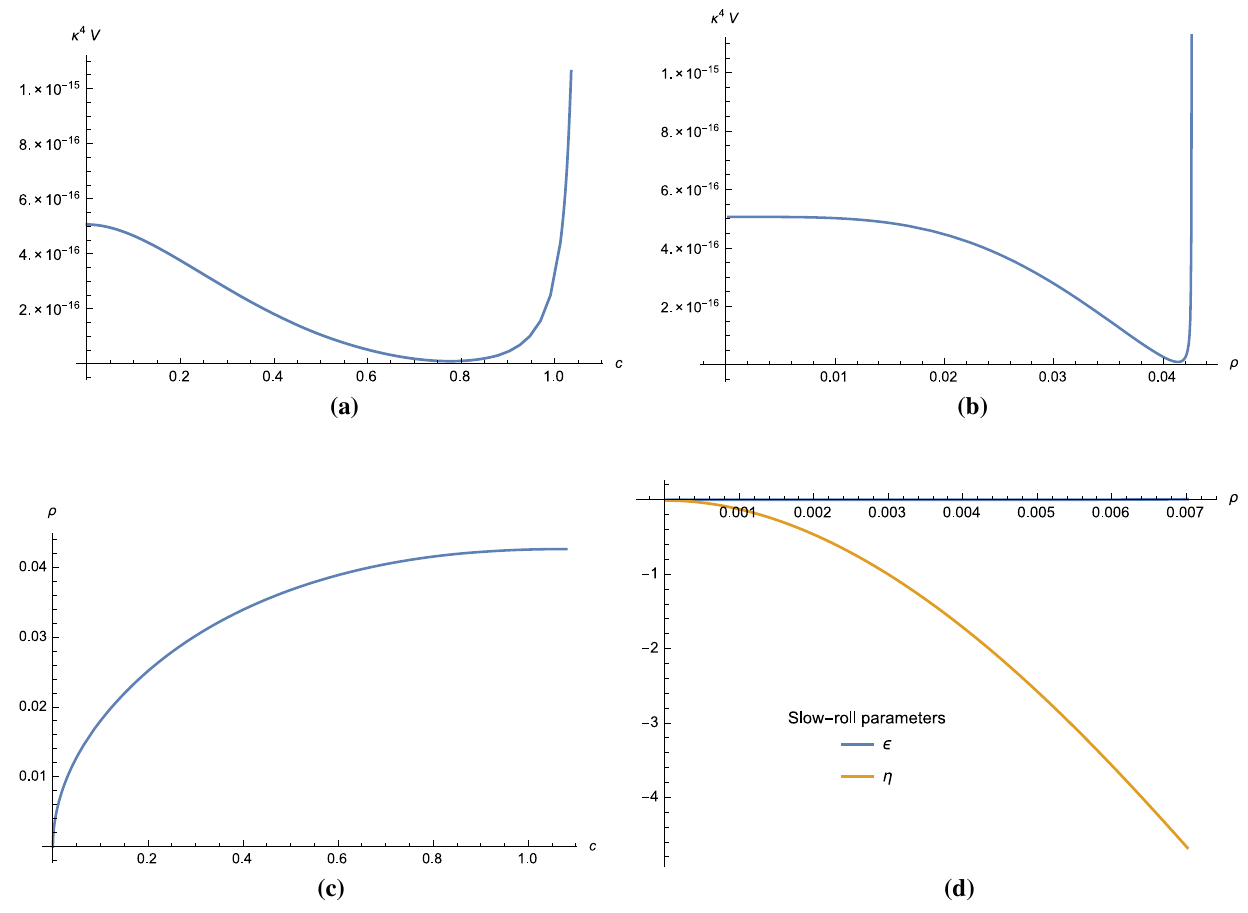
Fig. 2 The scalar potential for a model in Region I of Fig. 1 with parameters (5.27) is plotted as a function of c and ρ coordinates in a , b respectively. Plot in c shows the relation between ρ and c . The slow-roll parameters (cid:9) and η are shown in